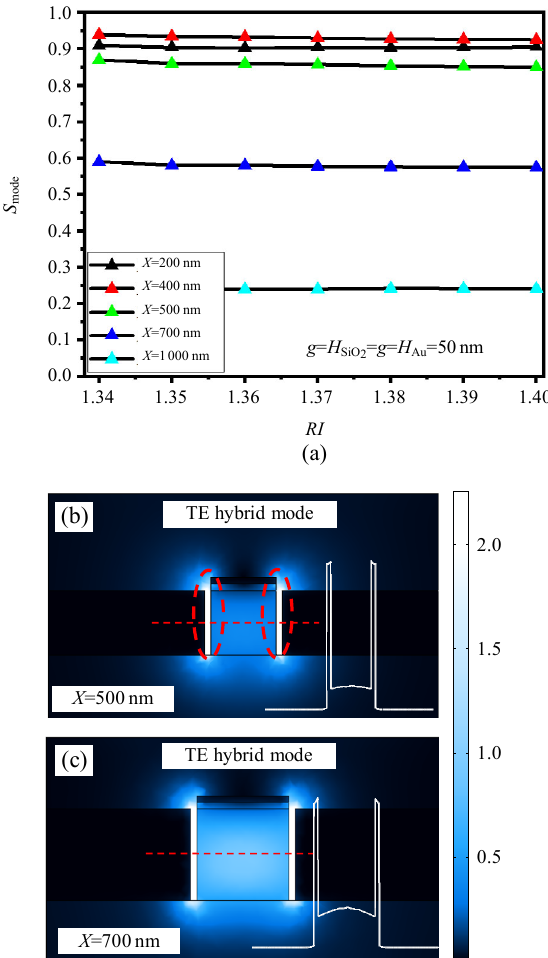
Fig. 5 Calculation of (a) mode sensitivity of the TE hybrid mode, (b) E-field distribution in the HPWG at X = 500 nm, and (c) E-field distribution in the HPWG at X = 700 nm. The remaining WG parameters such as H Au , g , and H SiO2 are fixed at 50 nm. Insets show the line graphs of the TE hybrid